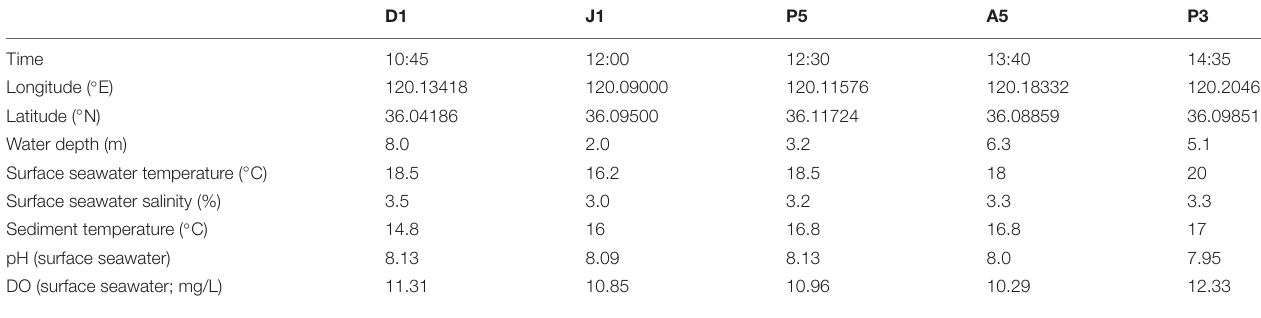
TABLE 2 | Environmental factors for Jiaozhou Bay sampling on 2008-10-26.